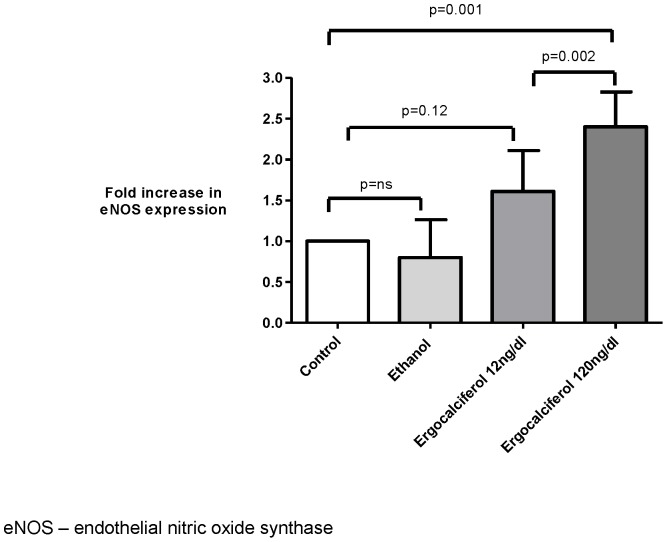
Fold increase in eNOS expression by RT-PCR in cultured HAEC.